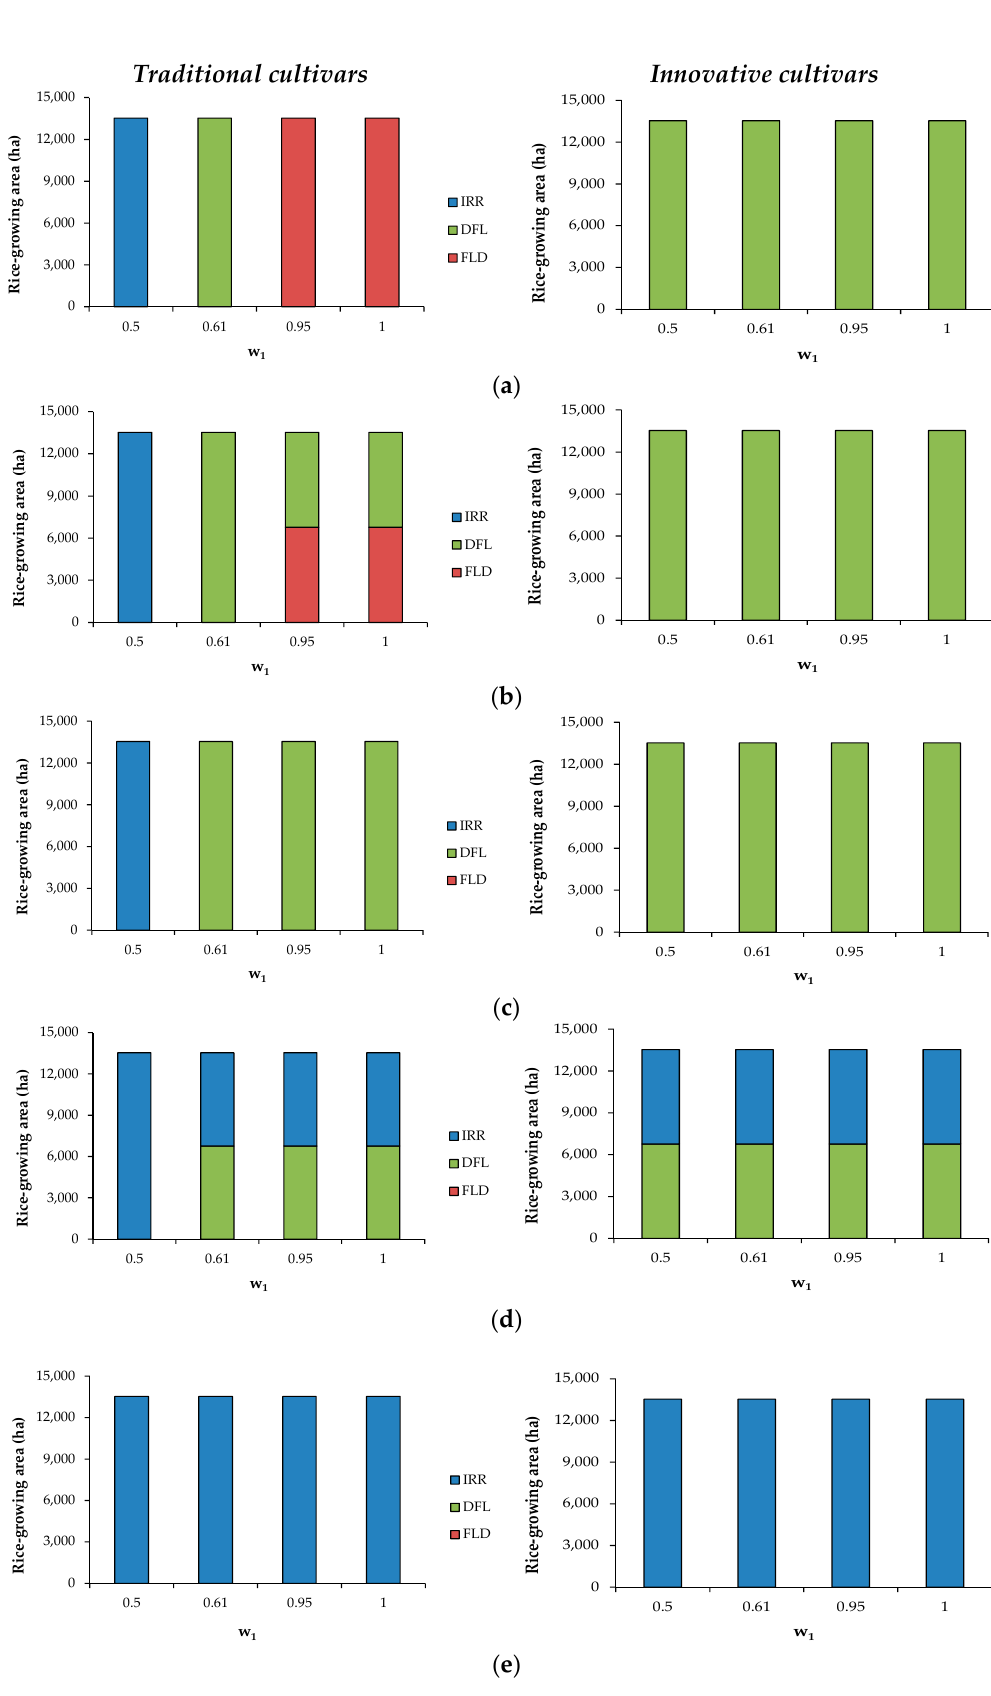
Figure 7. Optimal allocation of rice ‐ growing areas under different water availability levels (i.e., scenarios): ( a ) 2.19 L/s ∙ ha − 1 ; ( b ) 1.95 L/s ∙ ha − 1 ; ( c ) 1.70 L/s ∙ ha − 1 ; ( d ) 1.18 L/s ∙ ha − 1 ; ( e ) 0.66 L/s ∙ ha − 1 . Each scenario shows results of both prioritization weights and specific constraints: cultivation of traditional cultivars only or possible introduction of innovative cultivars.